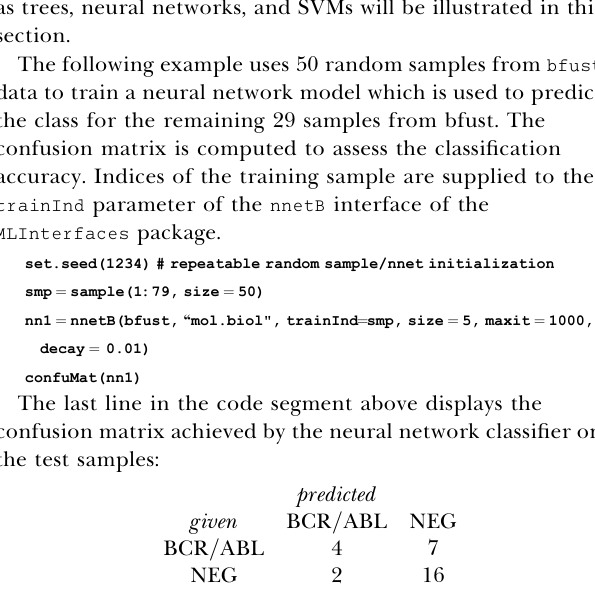
to machine learning, is to project the multidimensional data points onto two or three PCs which are the directions in the feature space showing the largest variability. The R packages pcurve and lattice are used here to compute the PCs and produce a plot of the 79 samples in bfust data (see Figure 6).